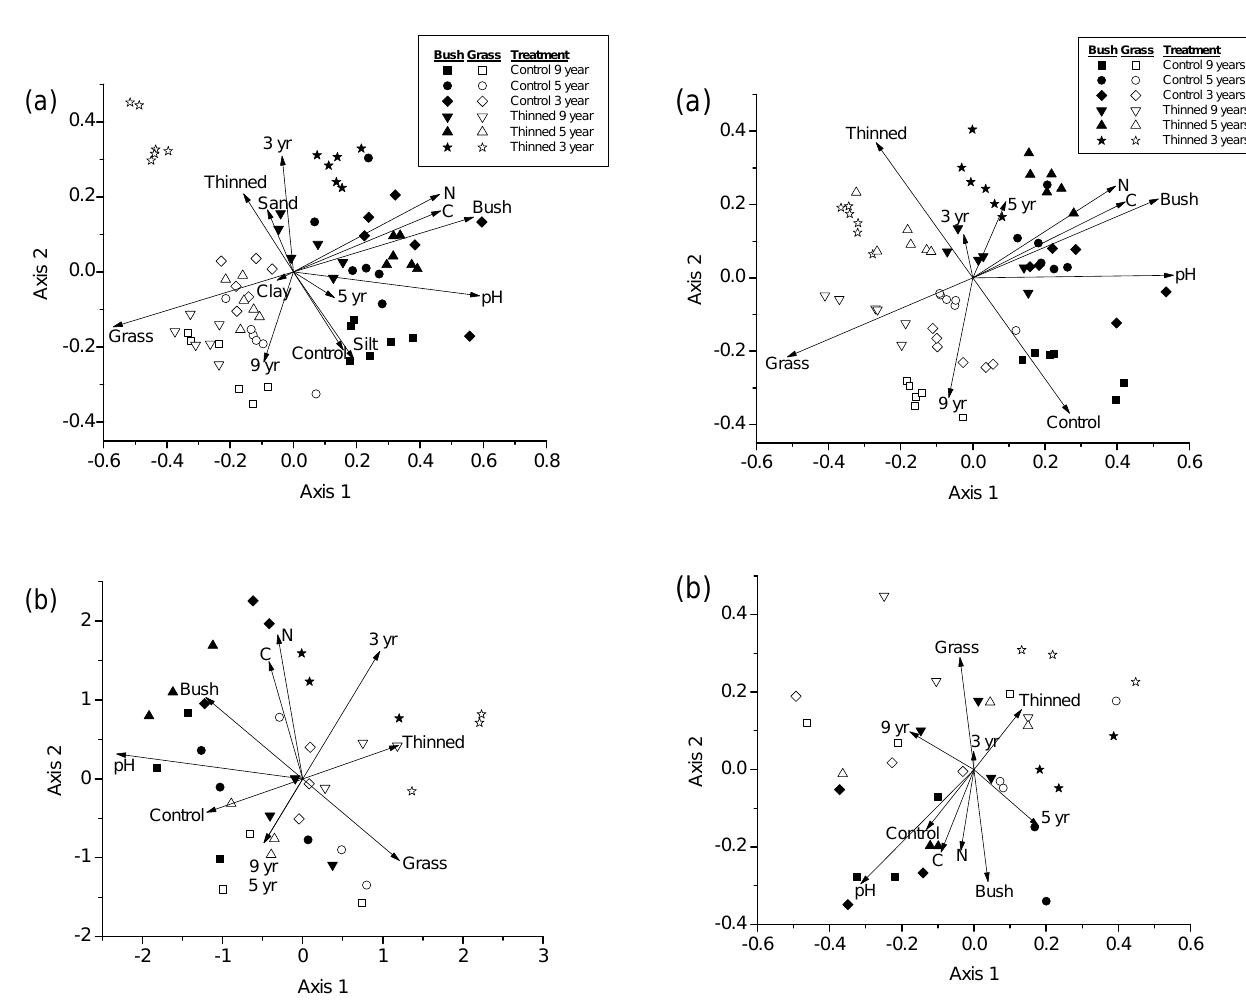
Figure 5. Redundancy analysis of archaeal TRFLP. (a) May and August 2012. (b) November 2013. Vectors indicate the correlations between each factor and the axes. Very small vectors were elimi- nated for the sake of